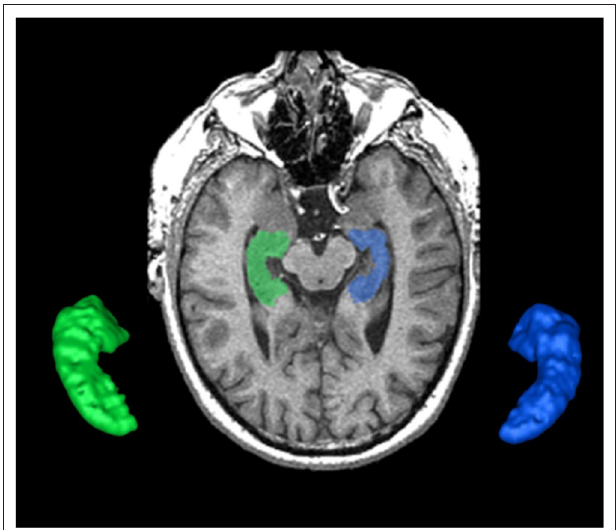
FIGURE 3 | The SunnyBrook Hippocampal Volumetric (SBHV) segmentation showing left (BLUE) and right (GREEN) hippocampi overlayed on an axial T1 MRI and extracted as 3-D surface volume renderings. Note images are in radiological